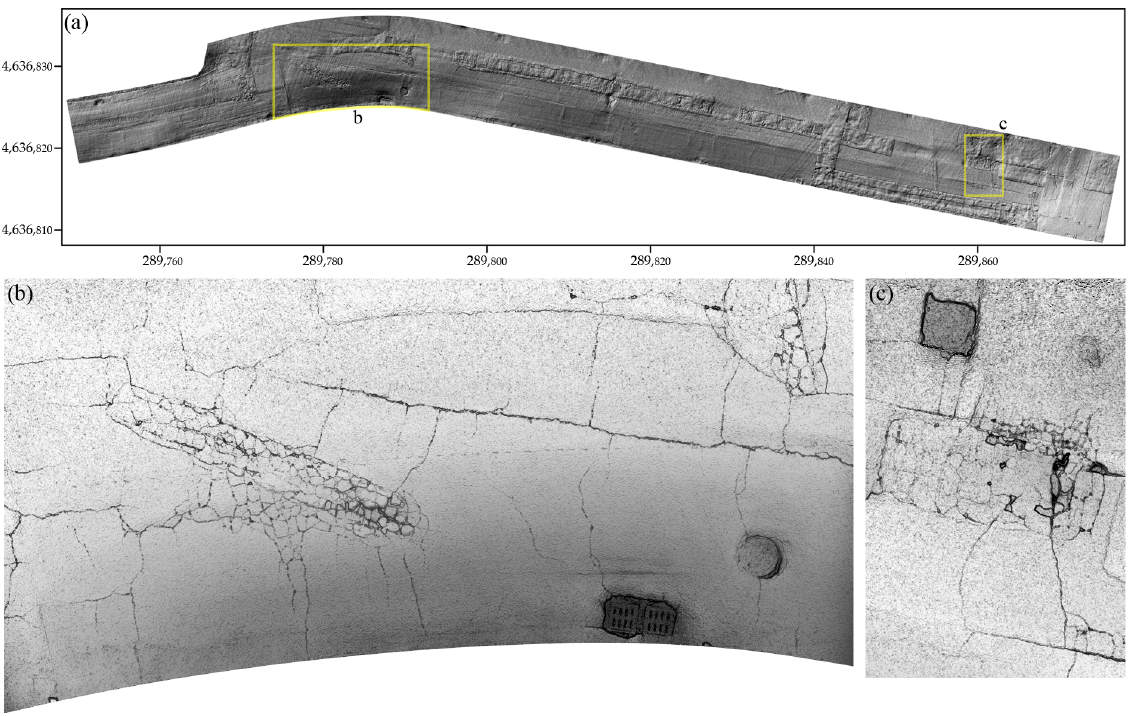
Figure 15. ( a ) DEMc of the whole analyzed road stretch, visualized in shadow relief; ( b , c ) Zoomed-in views of the DEMc sections highlighted with the yellow boxes in panel a .